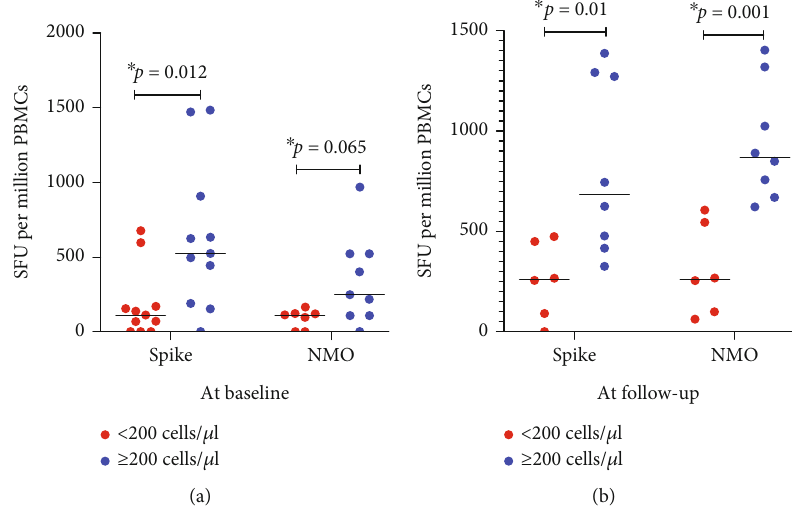
Figure 2: SARS-CoV-2-speci fi c T cell responses by CD4 counts. (a) SARS-CoV-2-speci fi c T cell responses against Spike S1 subunit and NMO peptide pools by CD4 count categories at baseline. (b) SARS-CoV-2-speci fi c T cell responses against Spike S1 subunit and NMO peptide pools by CD4 count categories at